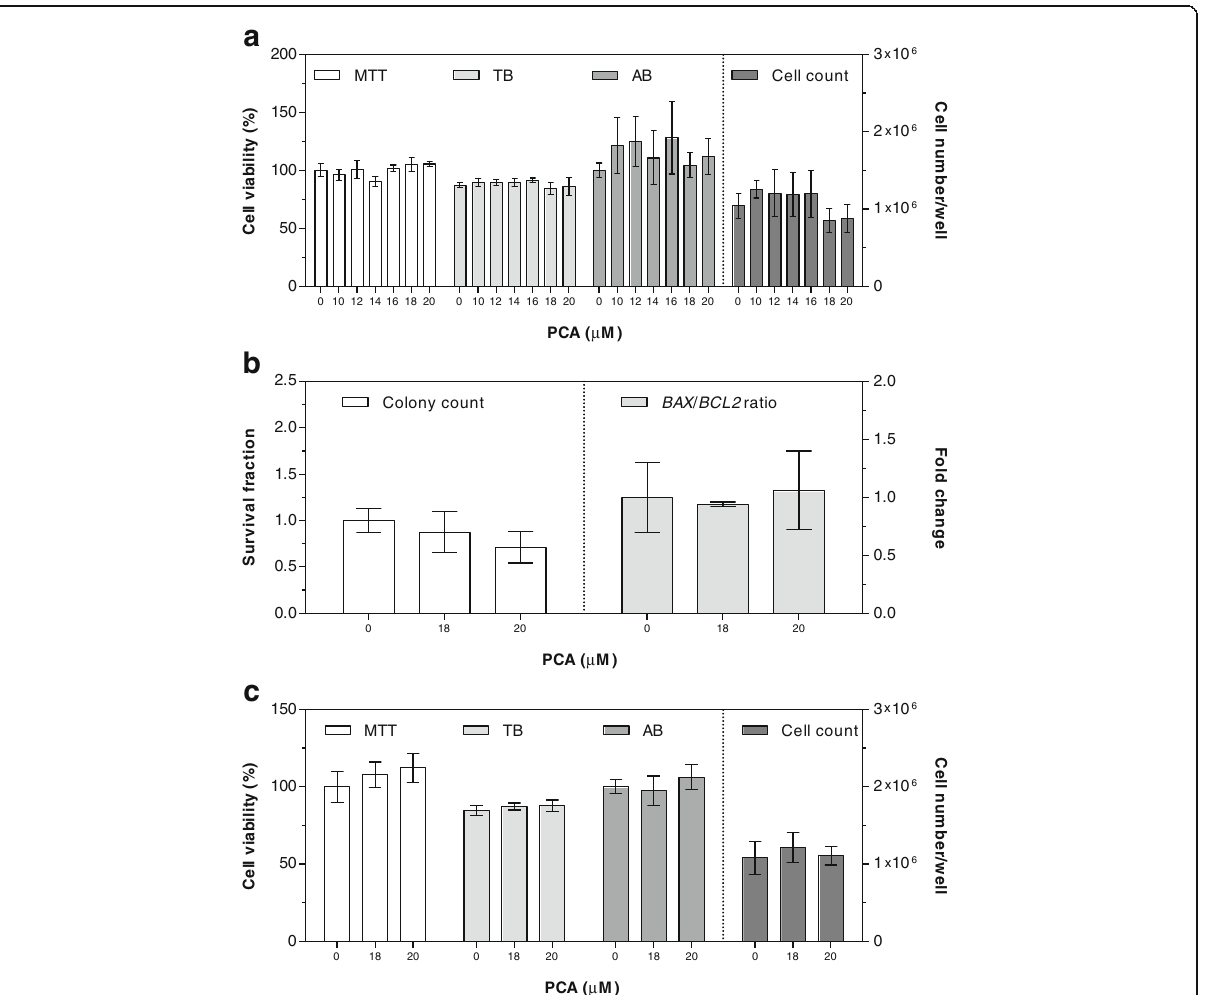
Fig. 4 Cytotoxic effects of PCA after 24 ( a , b ) and 48 ( c ) hours of supplementation. Cell viability by MTT and AB is expressed as percentage of control cells (assigned as 100%). TB is expressed as percentage of total cells. Cell count is expressed as number of cells per well. Colony count by clonogenic assay is expressed as survival fraction. BAX/BCL2 gene expression ratio is expressed as the mean fold change of relative expression compared to control cells, normalized to one. Data are means ± SD of six samples obtained from two independent experiments. Statistical analysis was by the one-way ANOVA (panel a : MTT, TB, AB, and cell count n.s.; panel b : colony count n.s., BAX/BCL2 ratio n.s.; panel c : MTT, TB, AB, and cell count n.s.) using Dunnett ’ s as post-test to compare supplemented cells to control ones